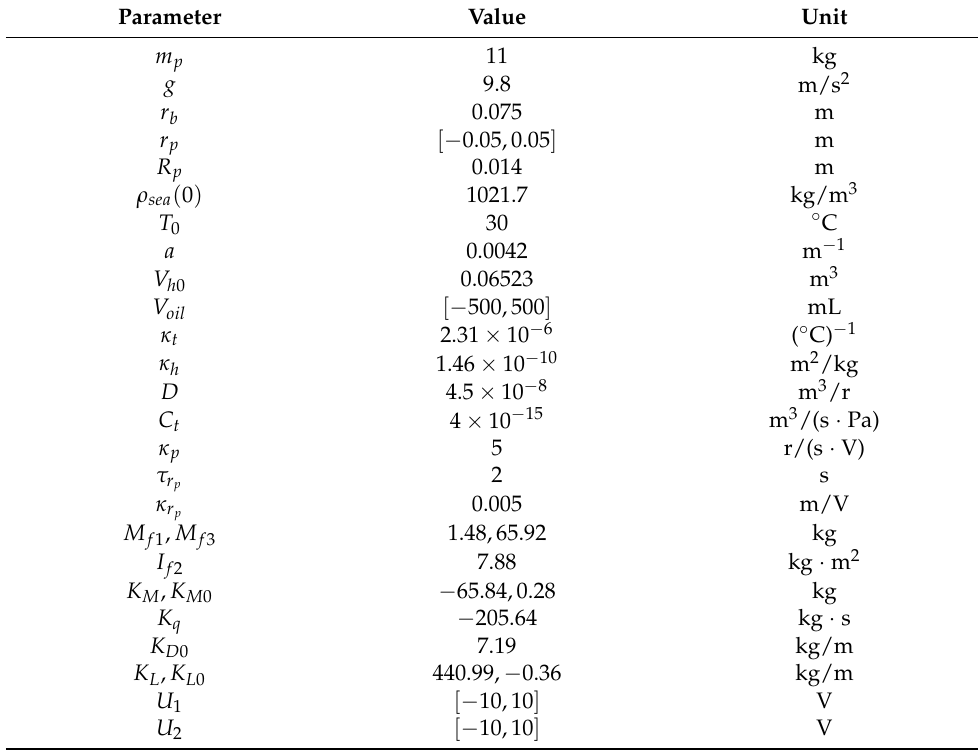
Table 1. Parameters of the underwater glider and seawater.